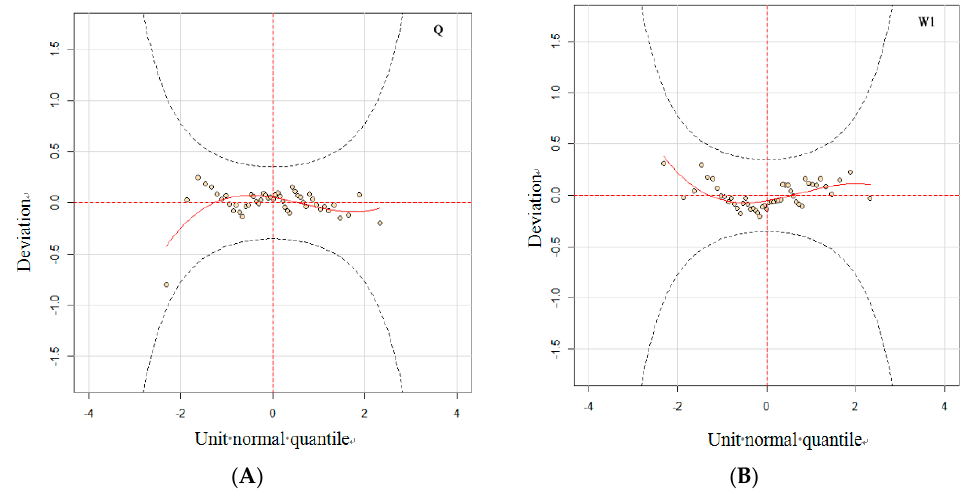
Figure 4. Worm plot of the residuals of non-stationary time-varying model with GAMLSS implementation ( Q in A , W 1 in B ). For a satisfactory fit of worm plot, all the observations should fall inside the two elliptic curves.